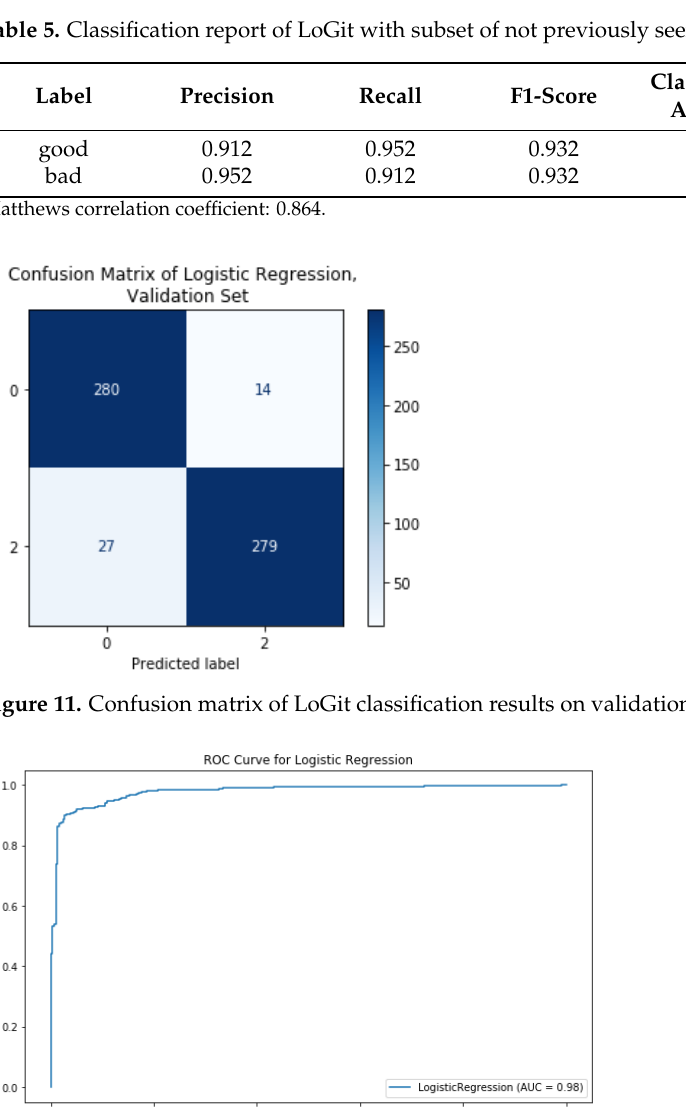
Figure 13. Receiver-operating characteristic curve for LoGit classification performance on valida- tion subset of 600 images.